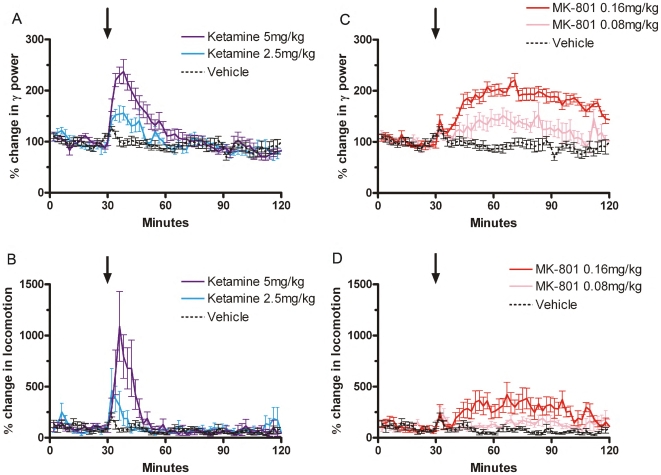
Ketamine and MK-801 induce parallel and dose-dependent increases in γ (30–80 Hz) power (A and C) and locomotor activity (B and D) in freely moving rats.Ketamine (2.5 and 5 mg/kg) or MK-801 (0.08 and 0.16 mg/kg) were injected subcutaneously. Black arrows indicate the injection time. Data are presented in 2-minute intervals, and represent the mean (±s.e.m.) percentage response compared to the 30 minute habituation period. Gamma power measurements represent the means of those obtained from the left and right hemispheres.